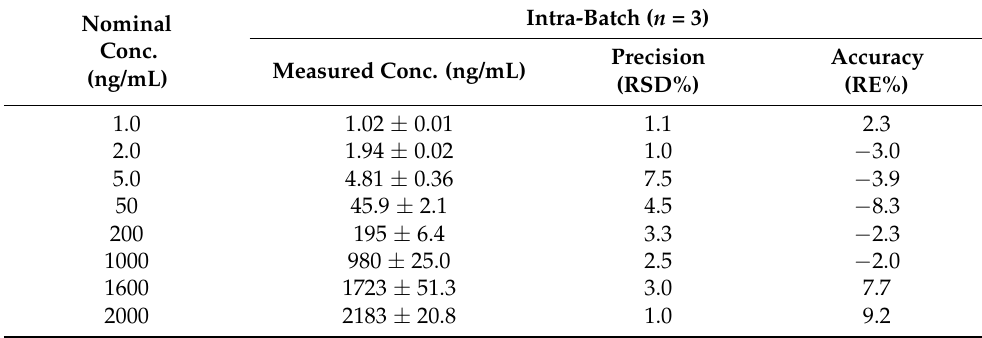
Table 3. Calibration curves of the LC-MS/MS method for PF in SD rat plasma. Nominal Conc.